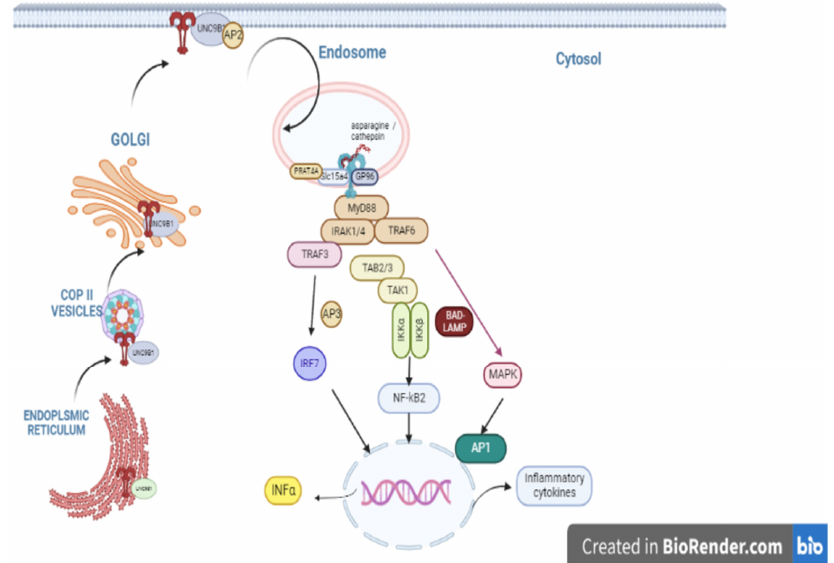
Figure 1. An overview of TLR9 trafficking and signaling pathway. TLR9s are synthesized in the ER to access the cell surface. They require chaperone molecules UNC93B1 to facilitate loading into COPII vesicles and transport to the Golgi. Then, reaching the Surface TLRs Trafficking to endosomes in DCs depends on AP 2, gp96, Slc15a4, and Slc15a4, accessory proteins needed for TLR9 transport. Upon entry into this compartment, TLR9 is proteolytically cleaved by cathepsins and AEP to gen- erate a mature form. It is in this compartment that signaling leads to activation of the NF- κ B path- way through (BAD-LAMP/LAMP5), controlling TLR9 trafficking or AP-3 to type I interferon sig- naling. The activation of TLR9- IRAK- TRAF signaling pathway triggers in turn the stimulation of transcription factors such as mitogen-activated protein kinase (MAPK), activator protein 1 (AP-1), and the nuclear factor NF- Κ b. TLR9-IRAK1-TRAF3 signaling cascade leads in turn to type I inter- feron.